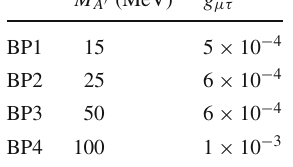
Table 1 Benchmark points in the ( g μτ , M A (cid:5) ) parameter